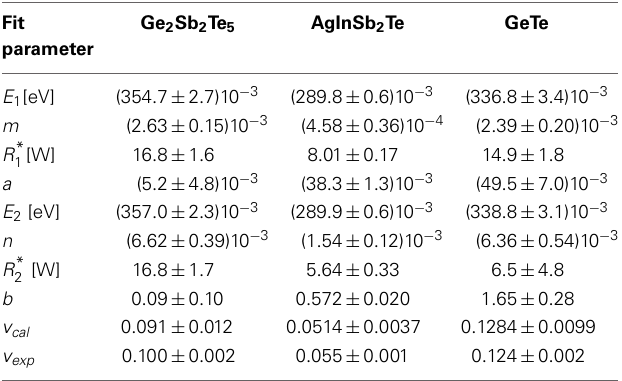
Table 2 | Fit parameters for the temporal evolution of the activation energy for conduction and the Arrhenius prefactor according to the Equations